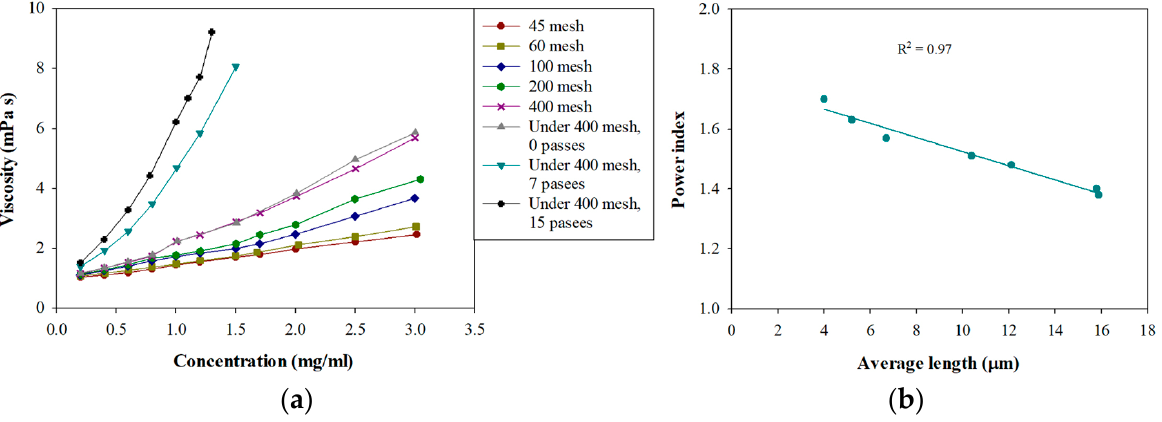
Figure 3. ( a ) Variation in the infinite shear viscosity according to the concentration of the different fractions of CNFs. ( b ) Variation in power index according to the average length of the CNFs.